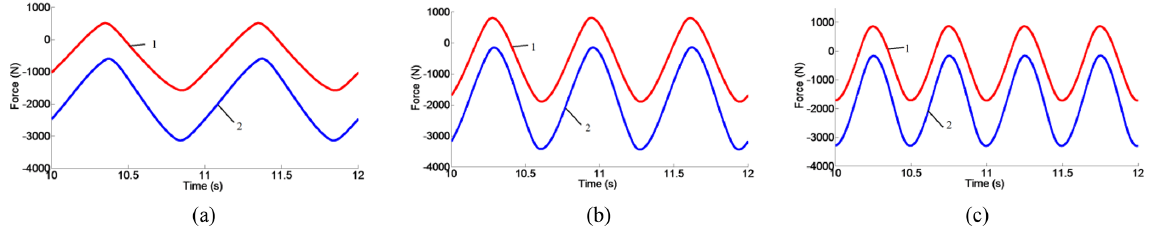
Figure 16. Force curves. Response curves of (a) 1.0Hz, (b) 1.5Hz and (c)